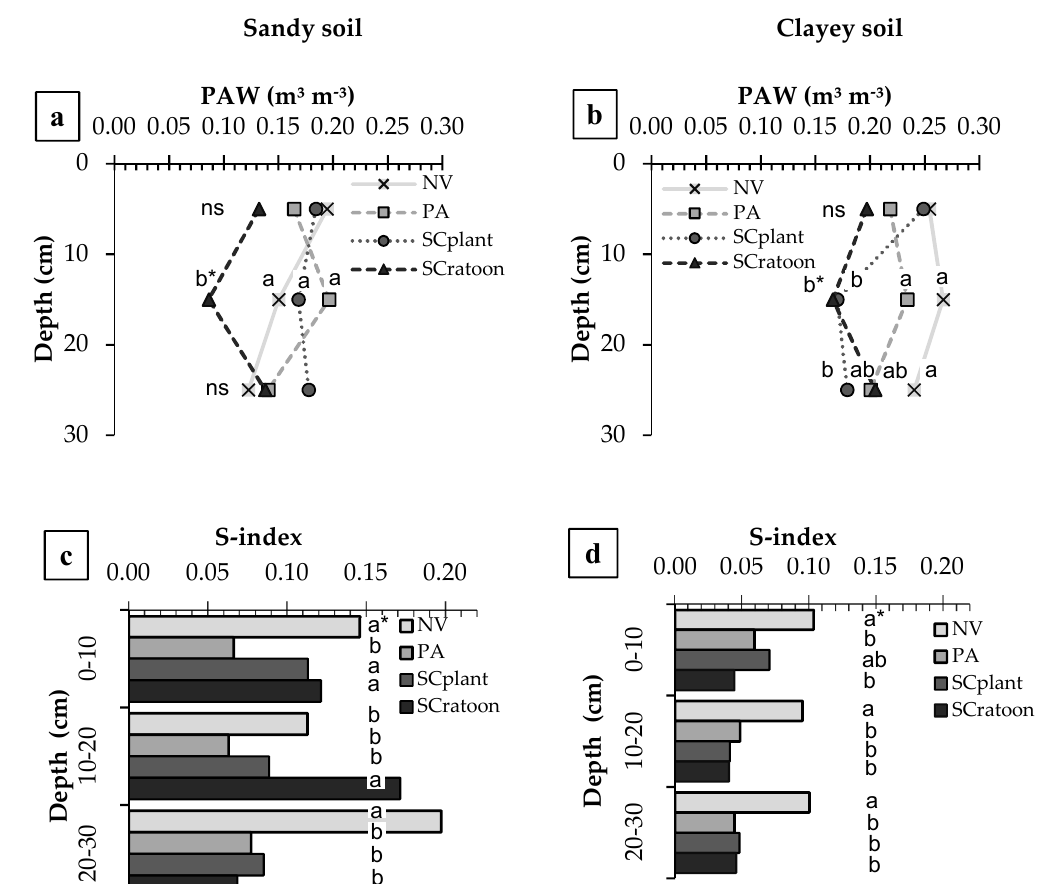
Figure 4. Average soil water retention curve (SWRC) from 0–10 ( a , b ), 10–20 ( c , d ), and 20–30 cm ( e , f ) layers under native vegetation (NV), pasture (PA), sugarcane plant (SCplant), and sugarcane ratoon (SCratoon) at Sandy soil ( a , c , e ) and Clayey soil ( b , d , f ).